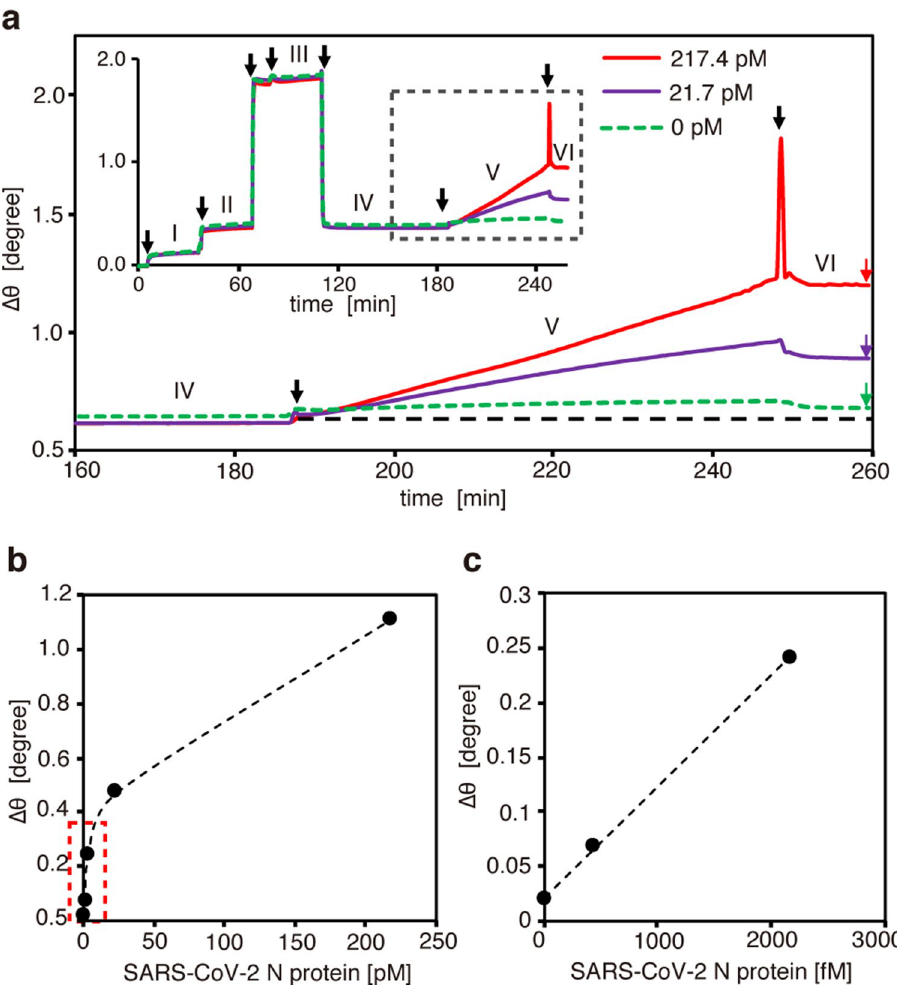
Figure 4. ( a ) Sensorgram of AuNP-enhanced SPR detection of SARS-CoV-2 N protein. ( b ) SPR angular shifts measured while increasing the concentration of SARS-CoV-2 N protein. ( c ) Enlarged view of the low- concentration region of ( b